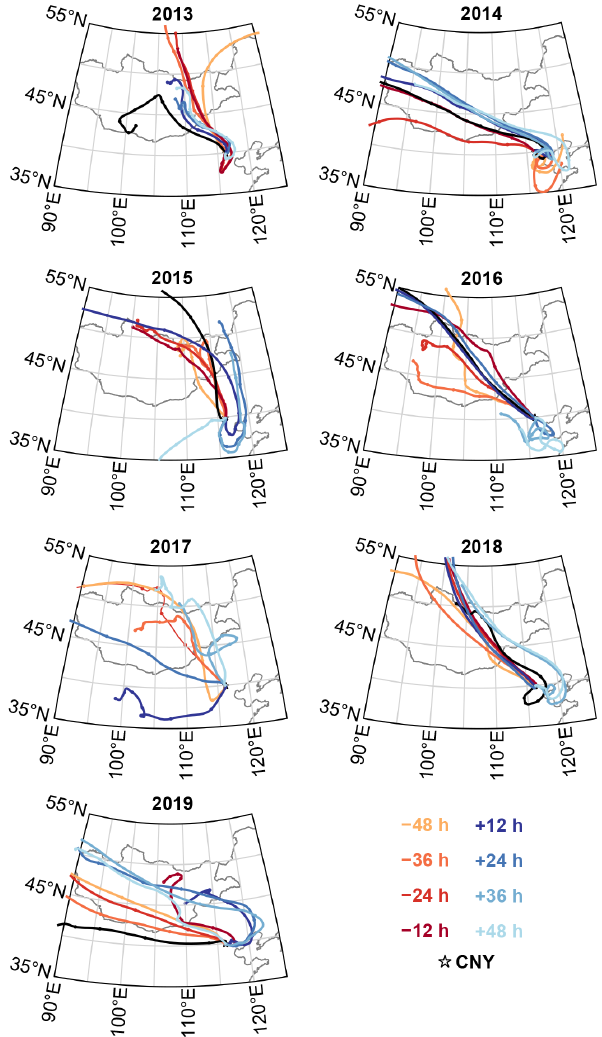
Figure 4. HYSPLIT 96h back trajectories for air masses arriving at BUCT-AHL between 18:00 and 06:00LT, the night of CNY in 2013 through 2019. The markers are every 12h.